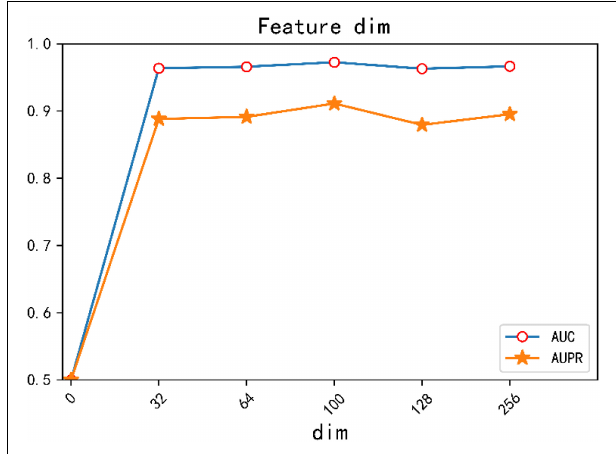
FIGURE 5 | AUC, AUPR values of different feature dimensions.